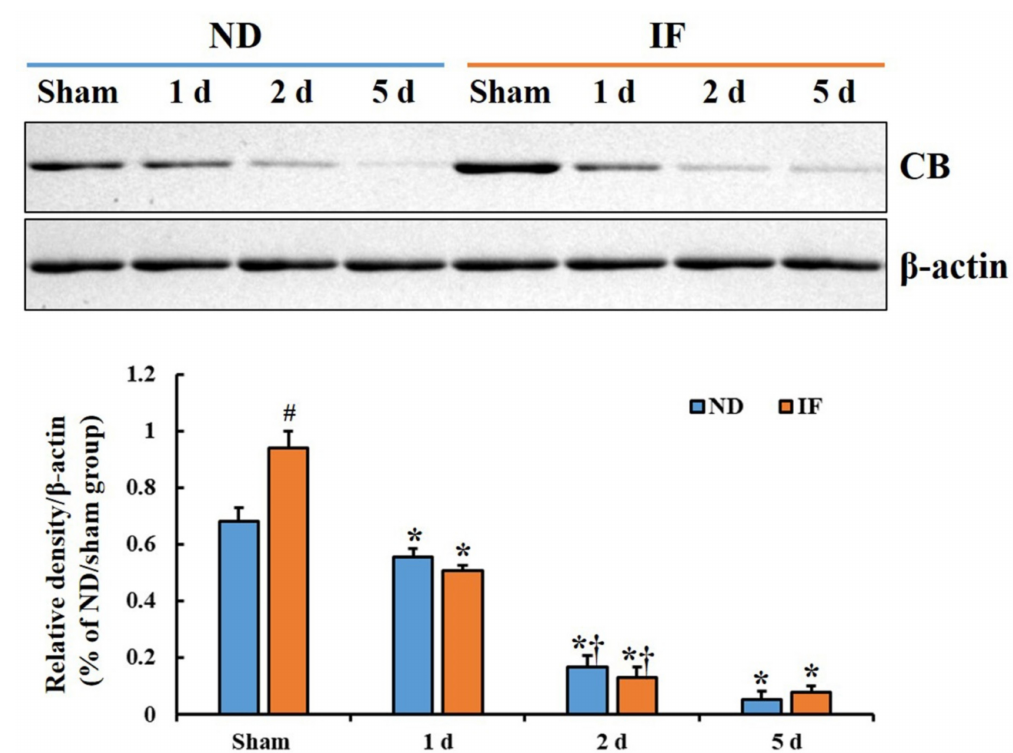
Figure 2. Representative blot images and quantitative analysis of CB protein in the hippocampal CA1 region of the ND/sham, IF/sham, ND/ischemia and IF/ischemia groups at sham, 1 day, 2 days, and 5 days after ischemia ( n = 5 at each point in time in each group, * p < 0.05 vs. sham group, # p < 0.05 vs. corresponding time point group of ND group, † p < 0.05 vs. pre-time point group of each group by post hoc Tukey’s test). Bars indicate means ± SEM. IF, intermittent fasting; ND, normal